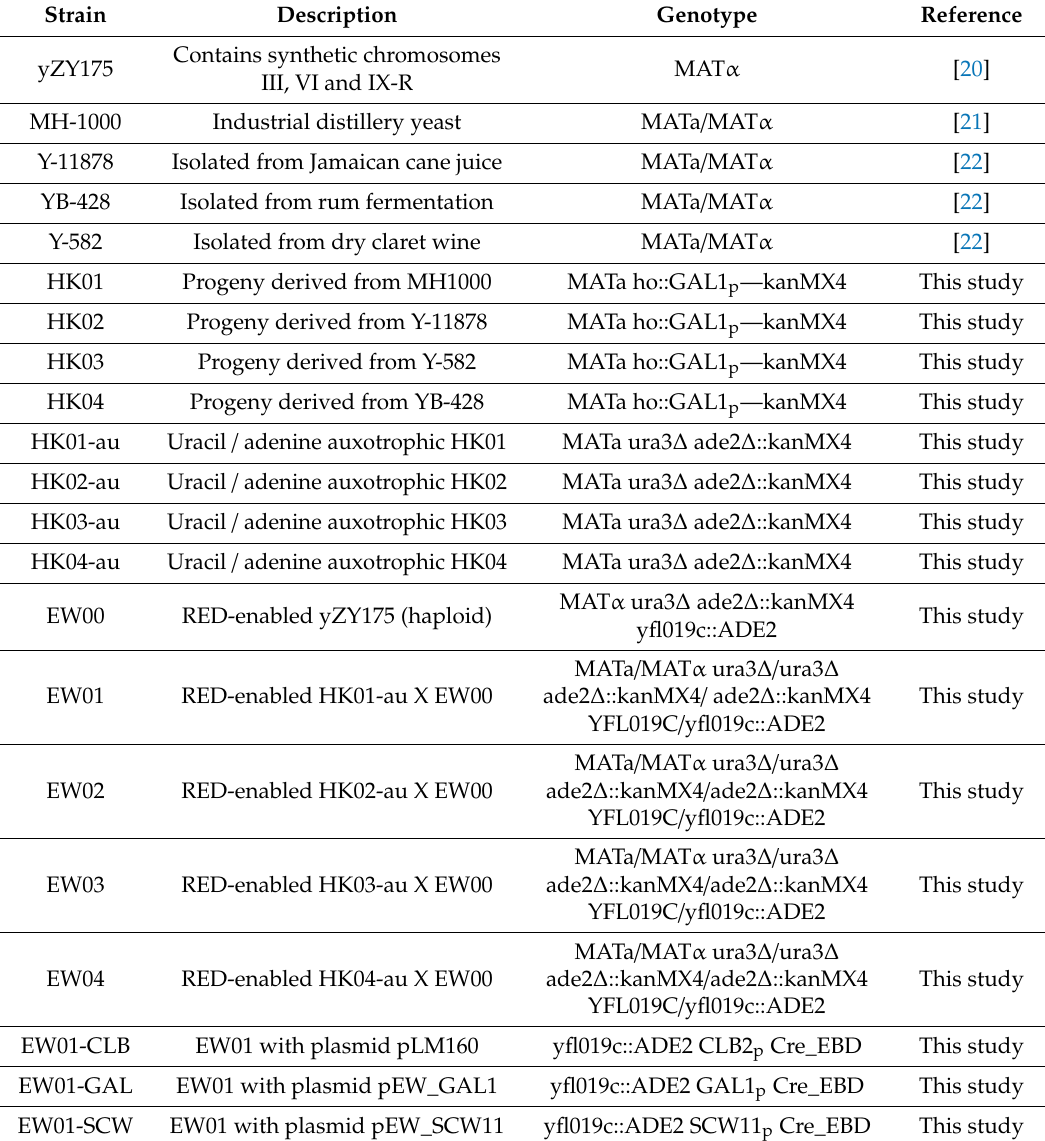
Table 2. Summary of relevant S. cerevisiae strains used in this